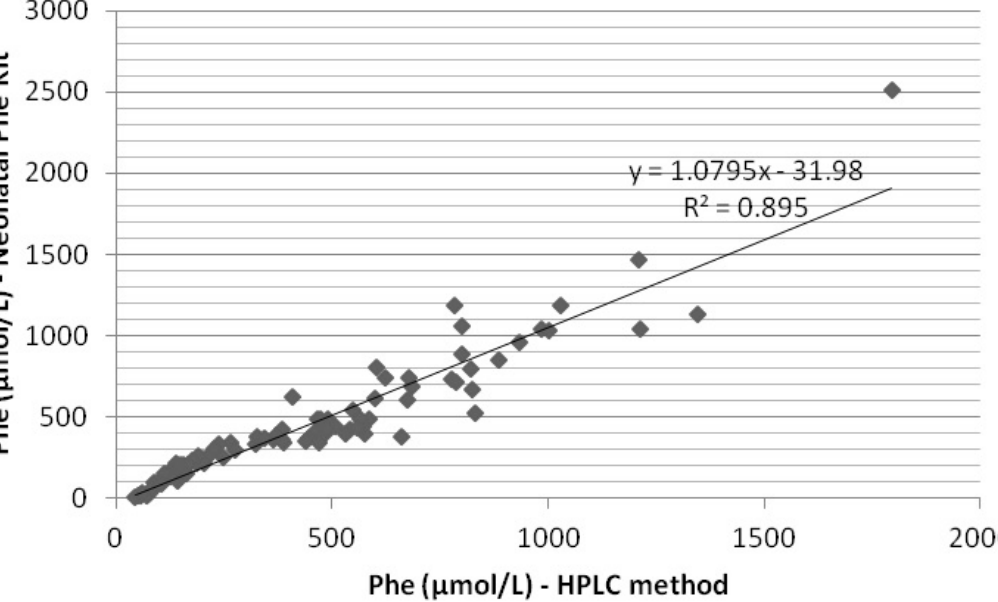
Figure 2. Correlation between phenylalanine (Phe) concentration in dried blood spots measured by the Neonatal Phe Kit (method B) and by high-performance liquid chromatography (HPLC) (n = 89 blood samples).